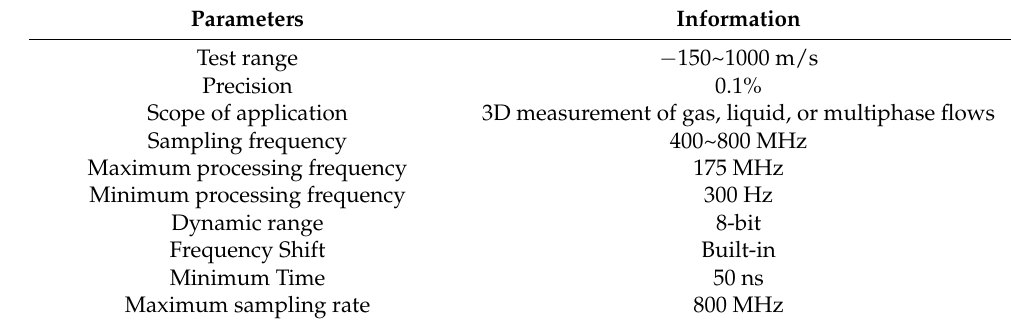
Table 2. Technical index of LDV test system.